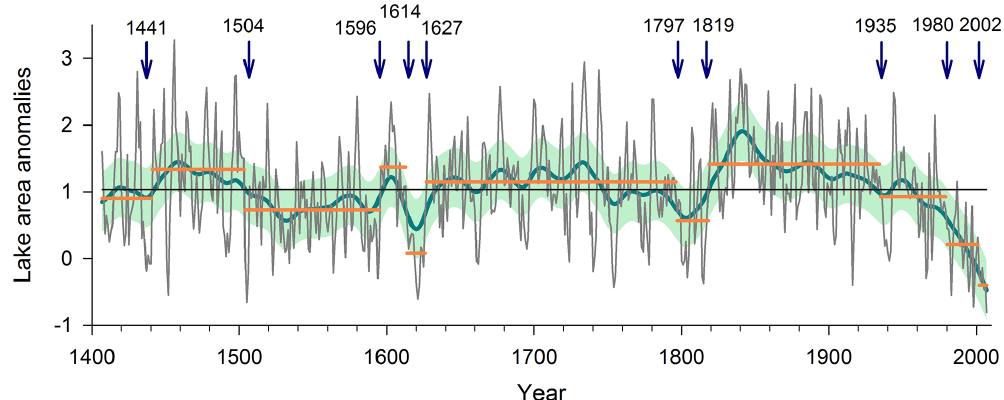
Figure 3. Annual (January–December) Vilama-Coruto lake area reconstruction for the period AD 1407–2007. Annual lake area expressed as Z score of the 1975–2007 lake area mean. The 35-year smoothing-spline curve highlights the multi-decadal variability. Significant (95%cl) regime shifts (blue arrows) and the mean of periods (orange horizontal line) detected by the Rodionov (2004) method (window length = 25years). Dates of the regime shifts are shown in the figure. Uncertainties of the reconstruction are shown by the light green band ( ± 1 RMSE). Table 2. Lowest and highest non-overlapping averages of the reconstructed (1407–2007) lake area fluctuations for the Vilama-Coruto lake system. Annual lake area expressed as Z score of the 1975–2007 lake area mean. Ranks 1–5 correspond to the five most extreme reconstructed lake area years or set of consecutive years. Rank 1 represents the most important minimum (maximum) lake area record. Rank Minimum lake area 1year